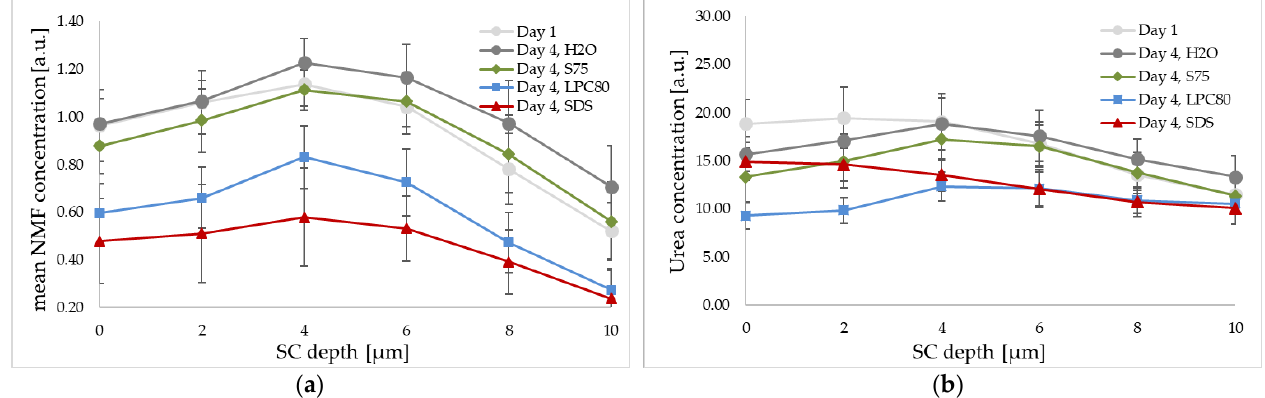
Figure 5. Effect of S75, LPC80, SDS and water on the relative natural moisturizing factor (NMF) ( a ) and urea concentration ( b ) of human forearm skin in vivo as determined by CRS. The NMF and urea signal intensity is given at different SC depths before the treatment (day one, light grey), and after four days of repeated exposure (day four, H 2 O in dark grey, S75 in green, LPC80 in blue and SDS in red). Values are means of n = 8 ± SD. The mean water concentration curves observed by CRS are given in Figure 6. Expo-